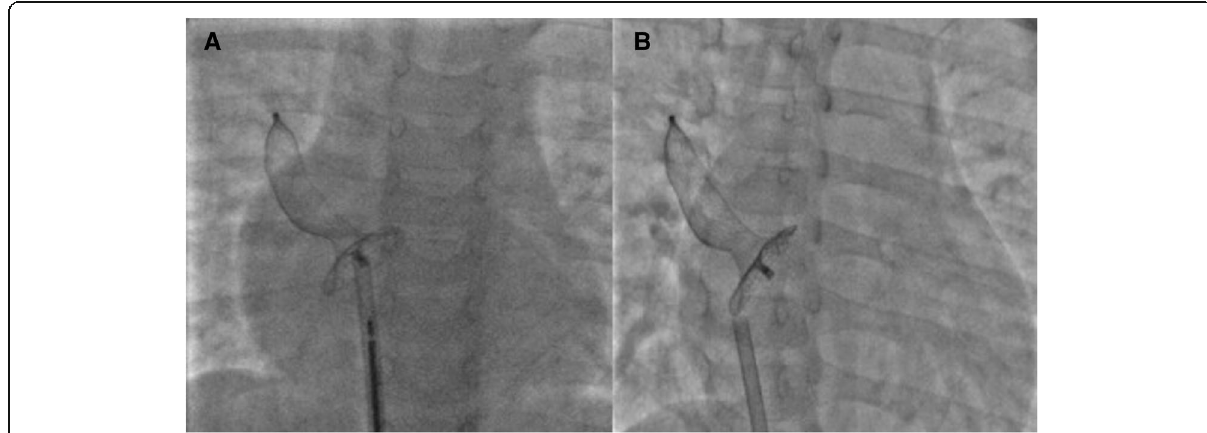
Fig. 4 Spontaneous detachment of the cable from the ASD closure device while manipulating from the right upper pulmonary vein ( A ) followed by loss of alignment ( B )